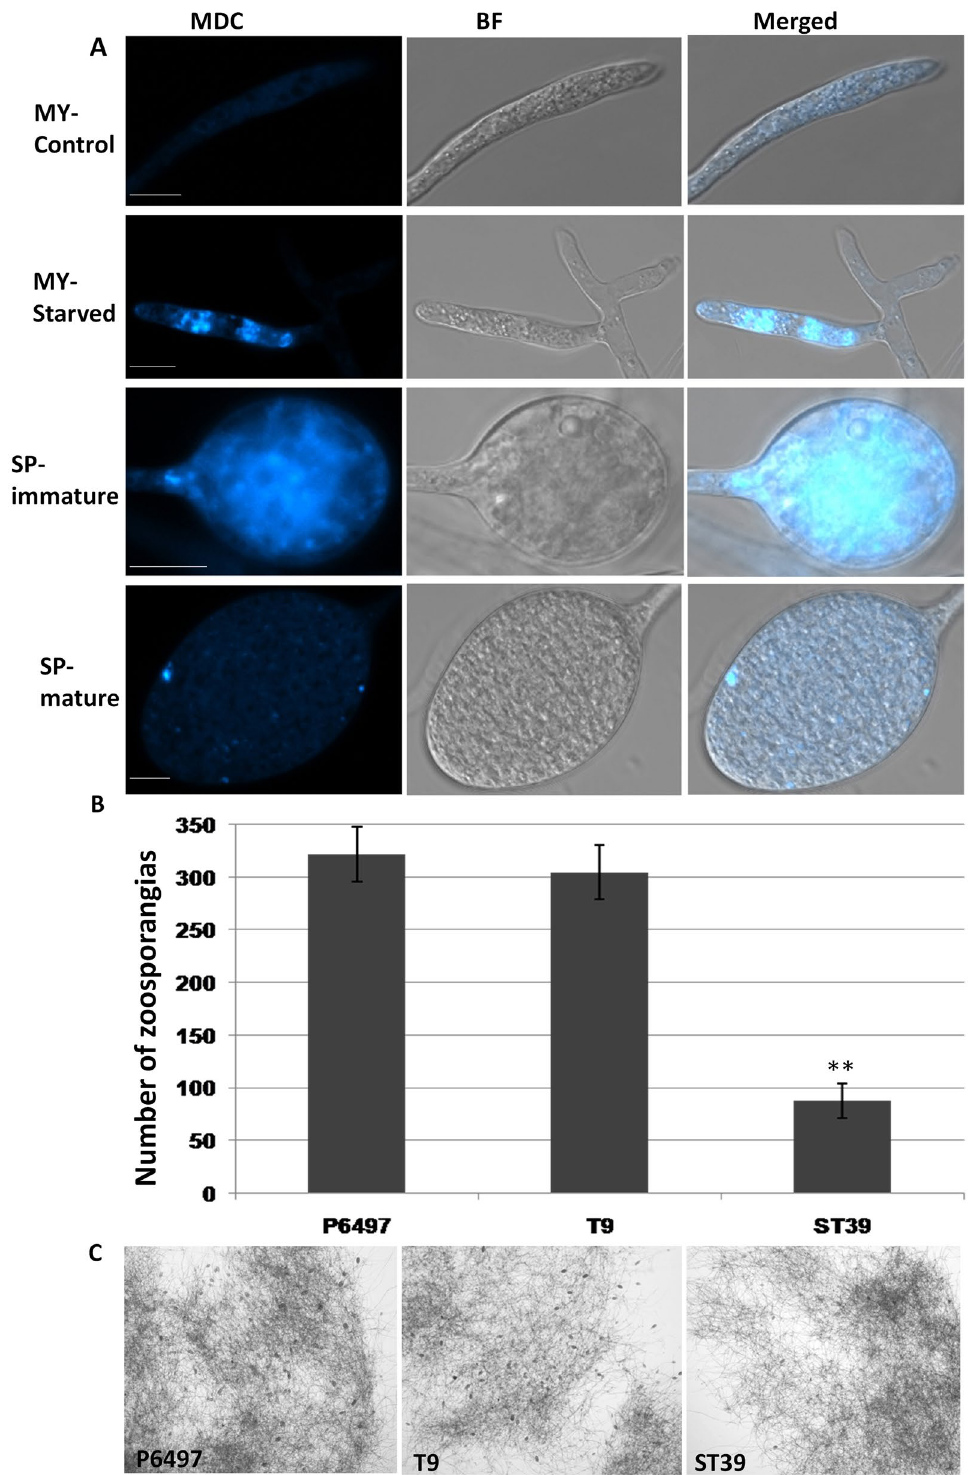
Figure 6. P. sojae sporangial production is regulated by autophagy. ( A ) Visualization of autophagic activation with MDC in P . soaje mycelia (MY) and zoosporangia (SP). Wild-type hyphae were incubated in 10% V8 juice for 30 h. After 3 washes and incubation with sterile distilled water for 4 h, hyphae were concurrently stained for MDC and analyzed by confocal microscopy. Bars = 10 μ m. ( B ) Numbers of sporangia produced by PsAtg6a transgenic lines. Sporangia of the indicated samples were counted 12 h after the induction of sporangial production. Representative data are shown from three separate experiments. The bars indicate standard errors, and stars above bars indicate that the difference from the wild-type value was significant. ** P < 0.01 ( t -test). ( C ) Sporangial phenotypes for PsAtg6a transgenic lines. Micrographs were taken 12 h after sporangial induction. Black arrows indicate sporangia. Bars = 500 μ